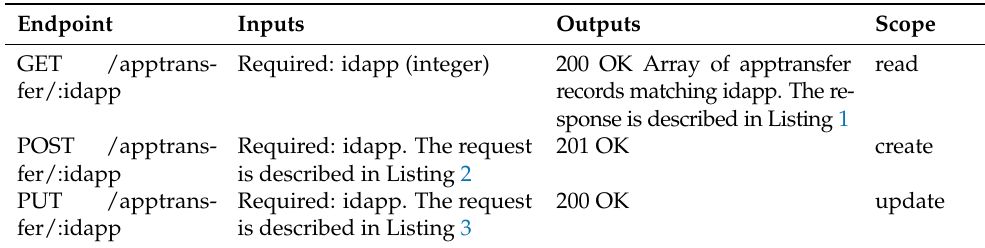
Table 4 shows the apptransfer endpoint specification. Table 4. API endpoint specification: